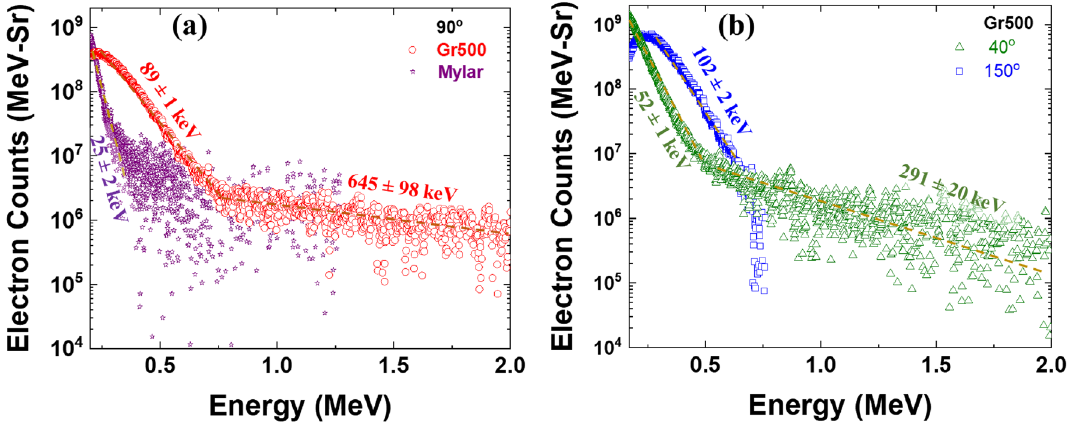
Figure 4. Electron spectra at ( a ) target rear normal (90°) for Gr500 and mylar substrate and ( b ) 40° and 150° at rear of